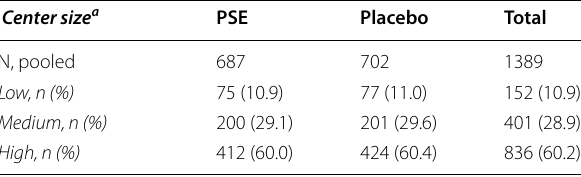
Table 3 Patients in low-, medium- and high-recruiting